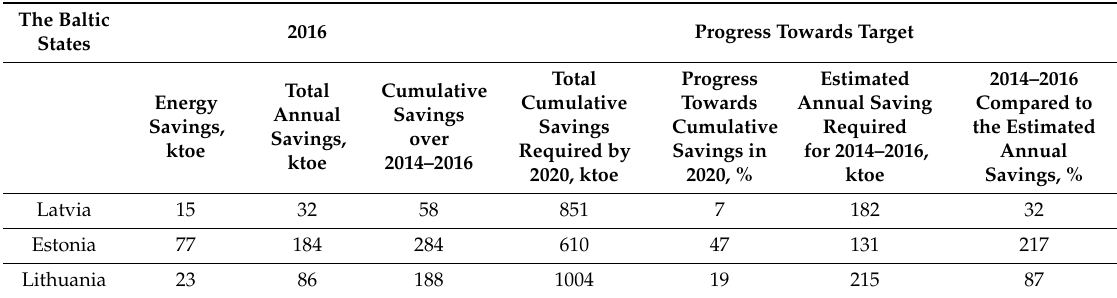
Table 3. National energy saving targets for the Baltic States in 2020 and results achieved until 2016. Source: created by authors based on [65].